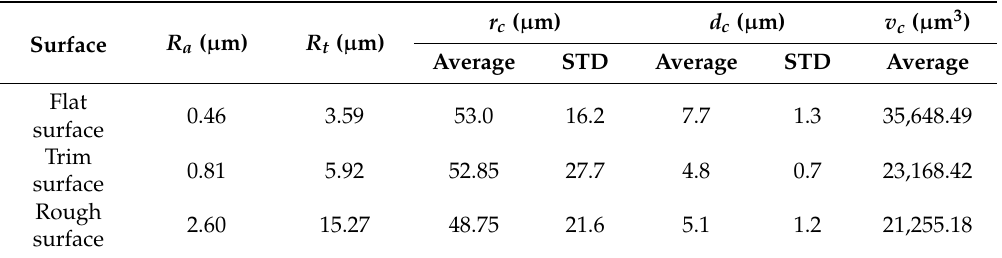
Figure 5. ( a ) Crater topography following a single-discharge experiment on a flat surface; ( b ) Determination of crater contour with ImageJ; ( c ) Measurement of crater depth. Table 4. Descriptive statistics of a crater produced by single discharge experiments on parts of varying roughness.